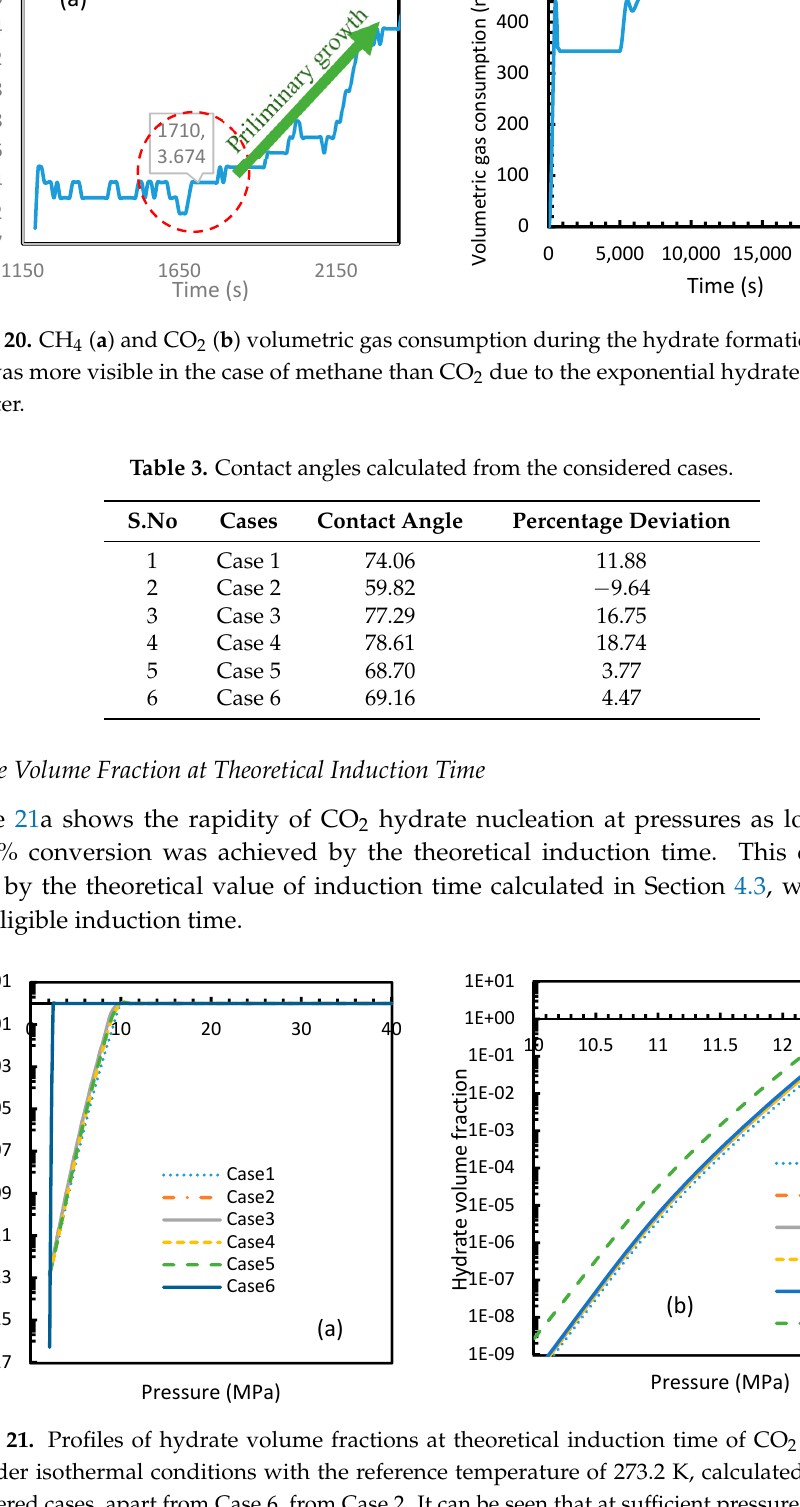
Figure 22. Profiles of hydrate volume fractions at theoretical induction time of CO 2 ( a ) and CH 4 ( b ) under isobaric conditions with reference pressure 30 MPa, calculated through the considered cases, apart from Case 6, from Case 2. The point of non-differentiability is found in case of Case 6 for CO 2 hydrates, indicating relative favorability of CO 2 for hydrate formation at high temperature, while the rest shows early depletion at relatively lower temperatures. From these results, it was concluded that the volume fraction of hydrates at the end of the theoretical induction time were not constant but dynamic. Hence, the observed induction time through temporal evolution of intensity of projected light might not be the same as the time hydrate formation become spontaneous. The reason could be ascribed to variable critical radius at various operational conditions. Due to mutual cancellation of deviations contributed by various internal parameters, the critical radius did not show any deviations among the considered cases.